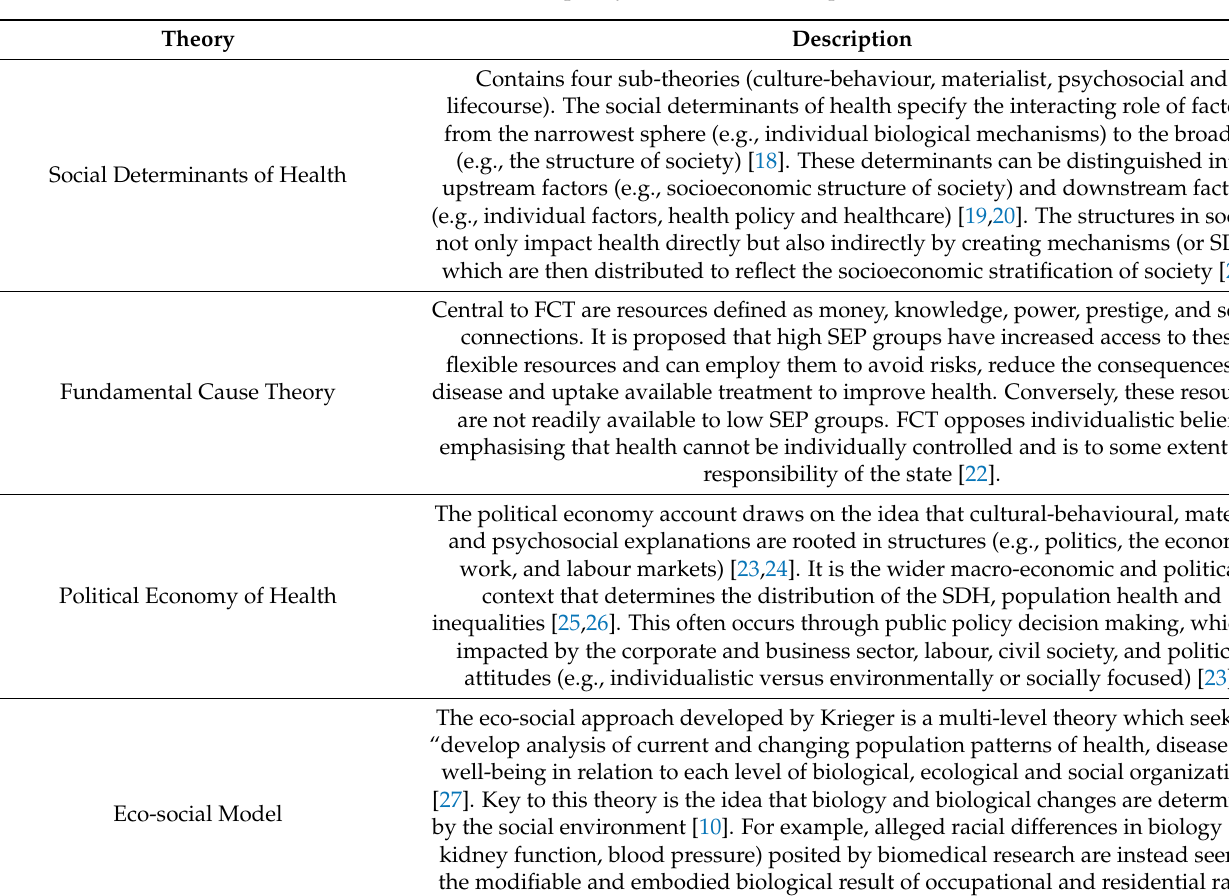
Table 1. Health inequality theories with